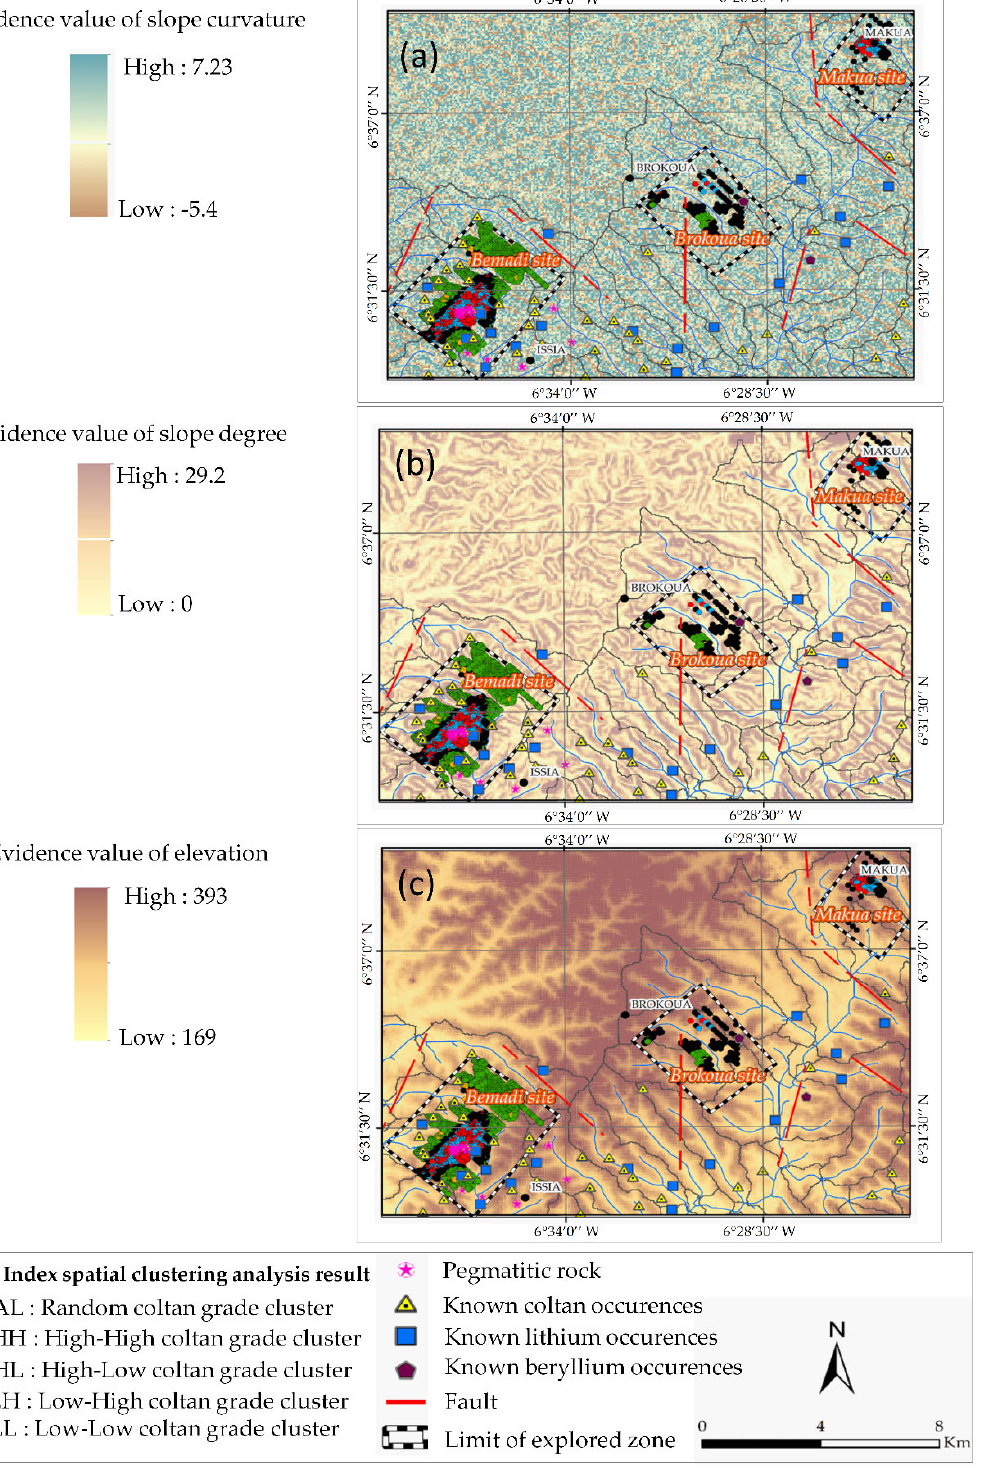
Figure 6. Evidence maps of geomorphologic parameters, ( a ): Slope curvature; ( b ): Slope inclination; and ( c ): Elevation (relief). Ochre-yellow to light brown pixels are the lowest topographic levels (riverbeds and gullies), while dark-brown pixels indicate increasingly higher elevation areas ranging from shallows to hillsides, plateaus, and ridges.